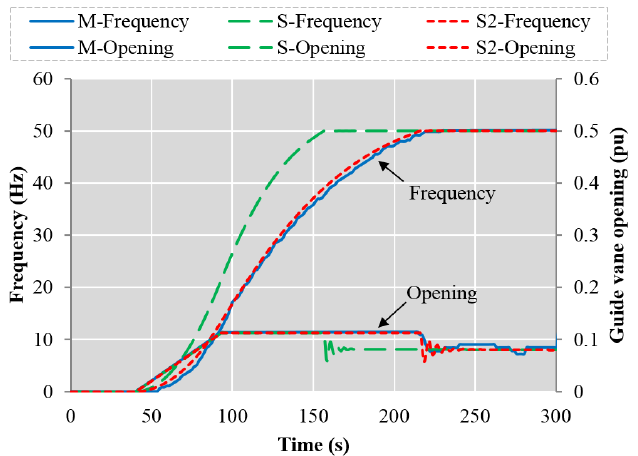
Figure 9. Frequency and opening from simulation and measurement during a start-up process (Case 2). The “S” means the simulation with the original characteristic curve of turbine, and the “S2” means the simulation with the modified characteristic